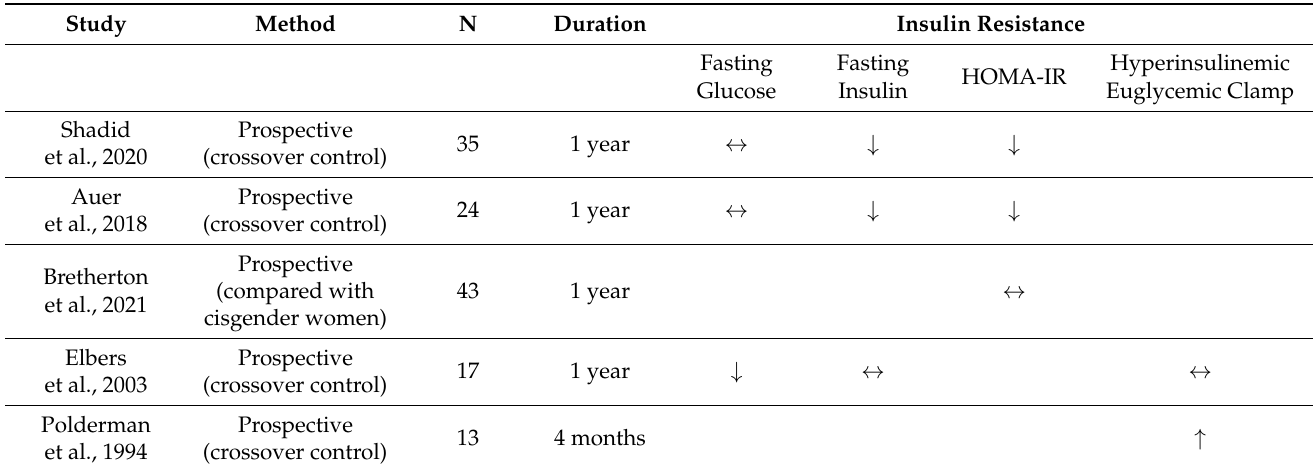
Table 1. Studies investigating insulin resistance in transgender males.